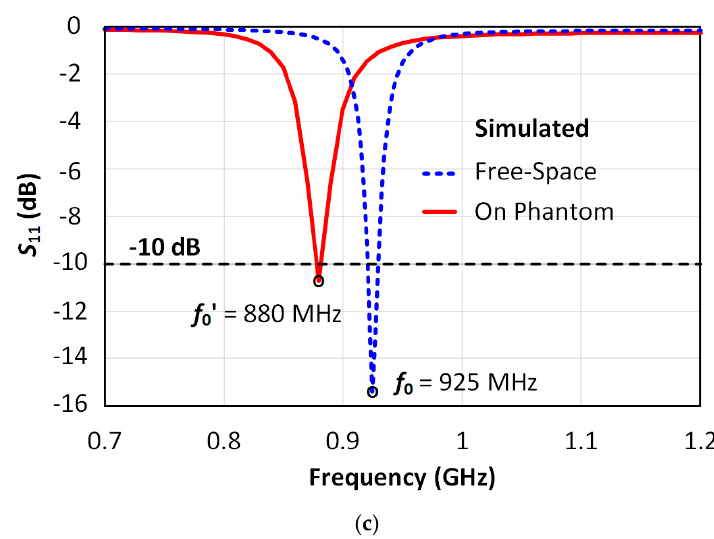
Figure 8. Simulated |S 11 |: ( a ) Simulated |S 11 | with parametric sweep of l CD ( l CE fixed to 8 mm) in free-space; ( b ) Simulated |S 11 | with sweep of l CE ( l CD fixed to 81 mm) in free-space; ( c ) Simulated |S 11 | with the final structure in free-space (dashed blue line) and on-wrist (solid red line).